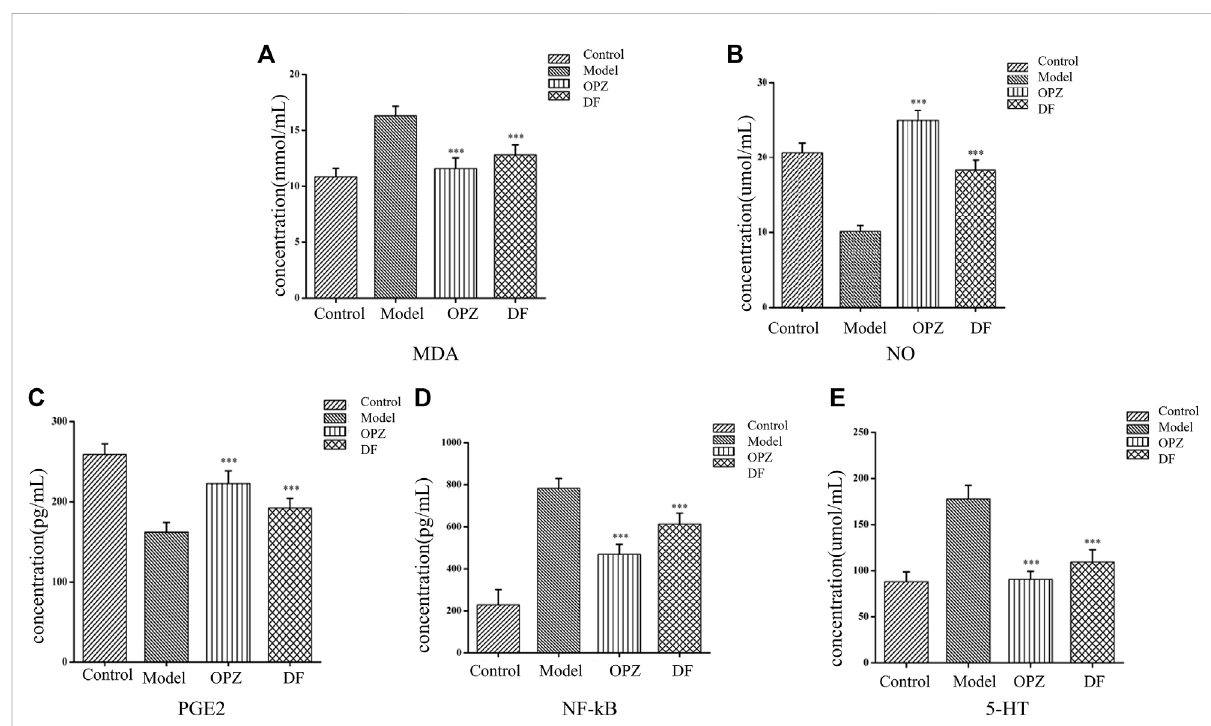
FIGURE 2 Effect of DF on the contents of MDA (A) , NO (B) , PGE2 (C) , NF- κ B (D) , as and 5-HT (E) in stomach of mice subjected to CTX-induced gastric ulcer. Data was expressed as mean ± SD ( n = 10). Data with different letters showed signi fi cant difference from each other ( *p < 0.05, **p < 0.01, ***p <